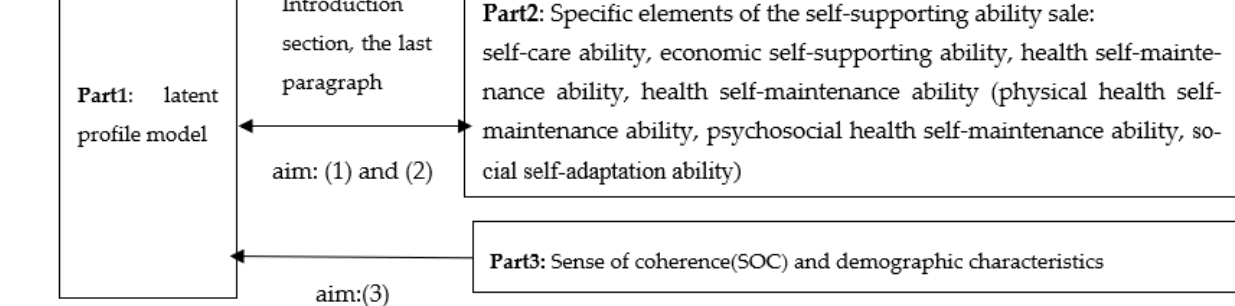
Figure 2. Specific framework diagram of current study.